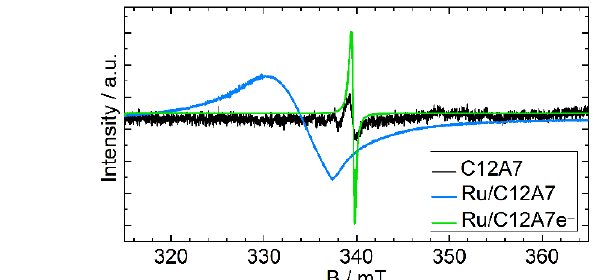
Figure 1. Left top to bottom: photographs of (f) 1.2 wt.%-Ru/C12A7 and (i) Ru/C12A7e − (3C) pow- Figure 1. ( Left top to bottom ): photographs of (f) 1.2 wt.%-Ru/C12A7 and (i) Ru/C12A7e − (3C) powders after Ru ders after Ru deposition. Right: DSC (heat flow, exothermic up, solid) and TG (m/m total , dashed) deposition. ( Right ): DSC (heat flow, exothermic up, solid) and TG (m/m total , dashed) curves under synthetic air for curves under synthetic air for (f) shown in black and (i) shown in red. 10 mg of sample each was (f) shown in black and (i) shown in red. 10 mg of sample each was heated with a ramp of 10 K · min − 1 from RT to 1573 K. heated with a ramp of 10 K · min −1 from RT to 1573 K.